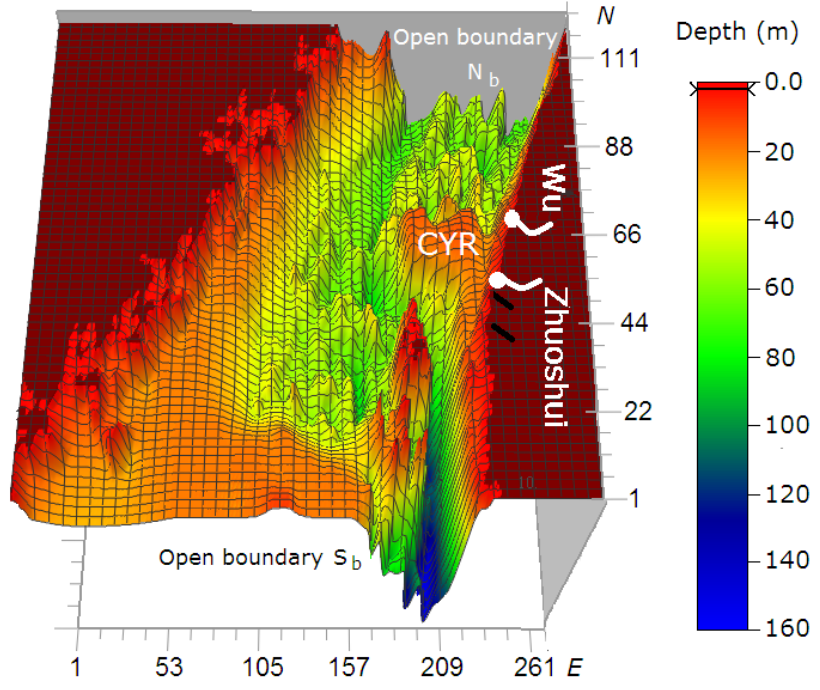
Figure 4. The POM domain and bottom topography. Locations of Zhuoshui River and Wu River mouths are indicated by white dots.